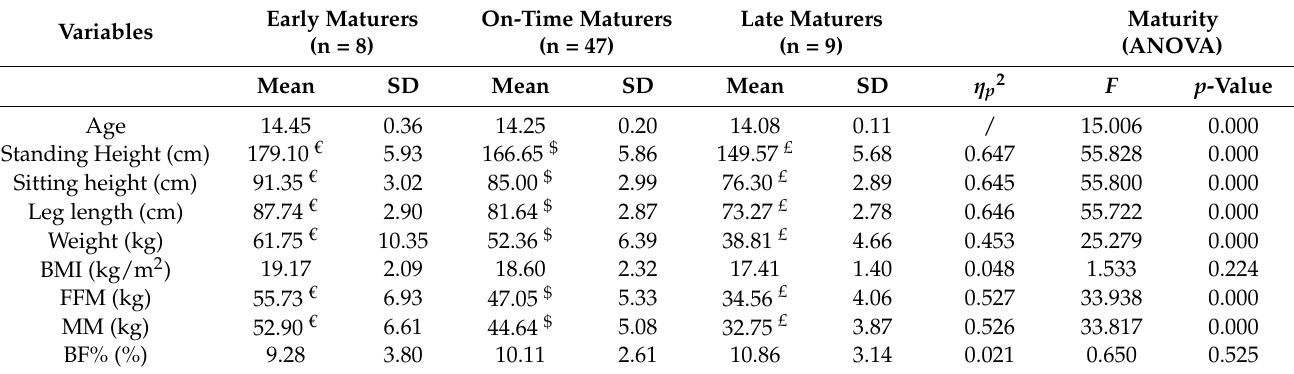
Table 1. Anthropometric and body composition characteristics by maturity